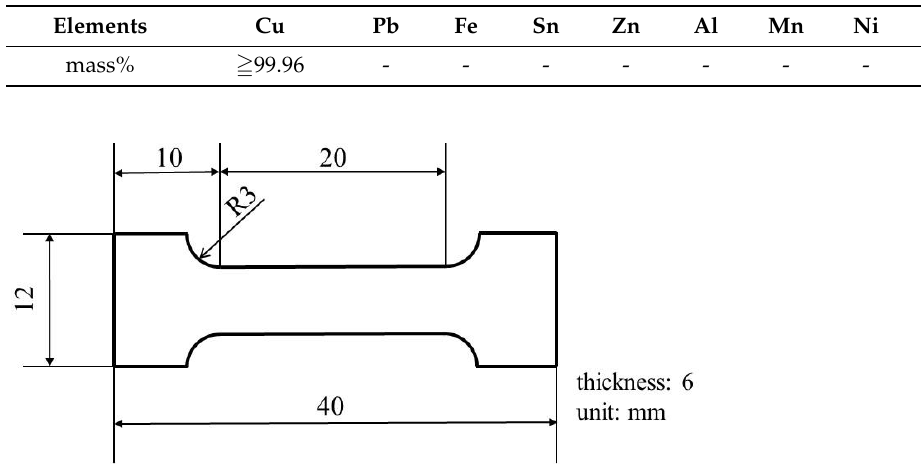
Table 1. Chemical composition of C1020 used in this study.